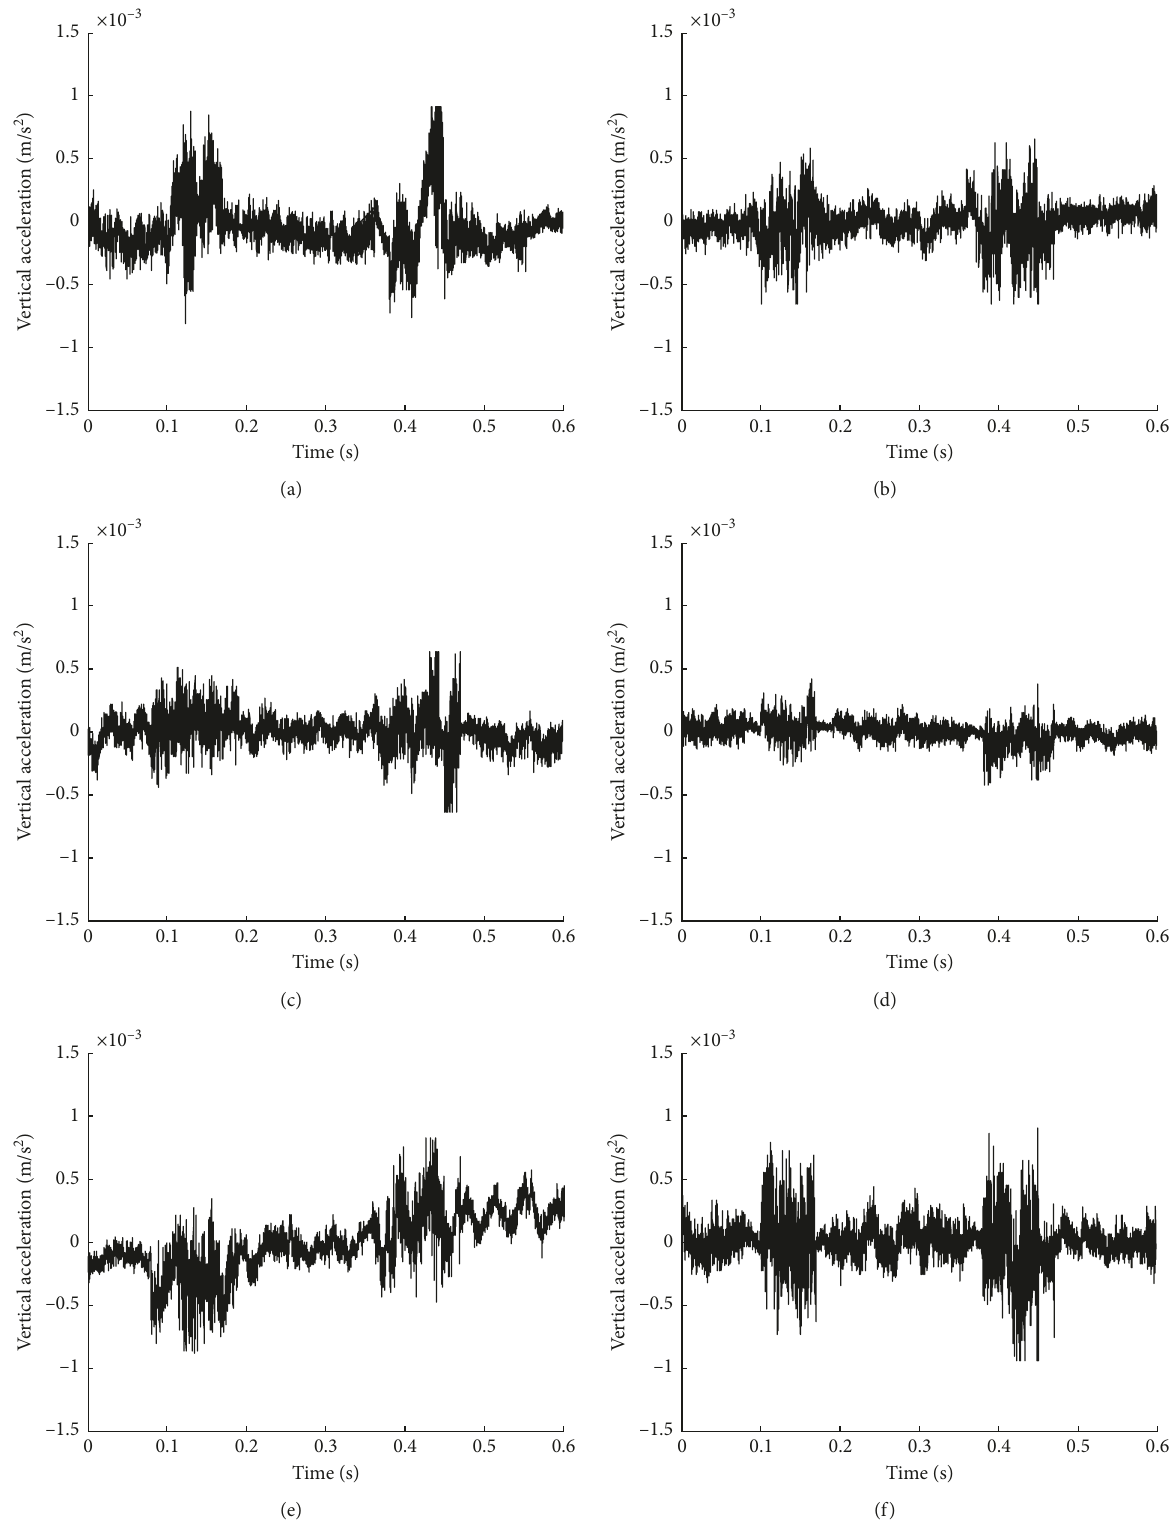
Figure 10: Vertical dynamic response of soil under train-induced vibration load. (a) Testing point A4 without an open trench. (b) Testing point A4 with an open trench. (c) Testing point A14 without an open trench. (d) Testing point A14 with an open trench. (e) Testing point A13 without an open trench. (f) Testing point A13 with an open